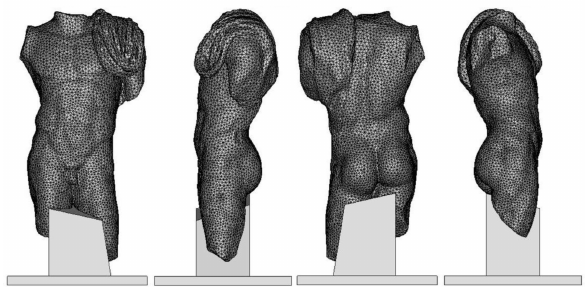
Figure 2. Picture of the project for the base of the statue (Bagnéris et al., 2014) Thereby, the field of the sculptural restoration seems to create more respectful and discreet methods, by seeking innovative ways to generate new knowledge on this sculptural heritage.